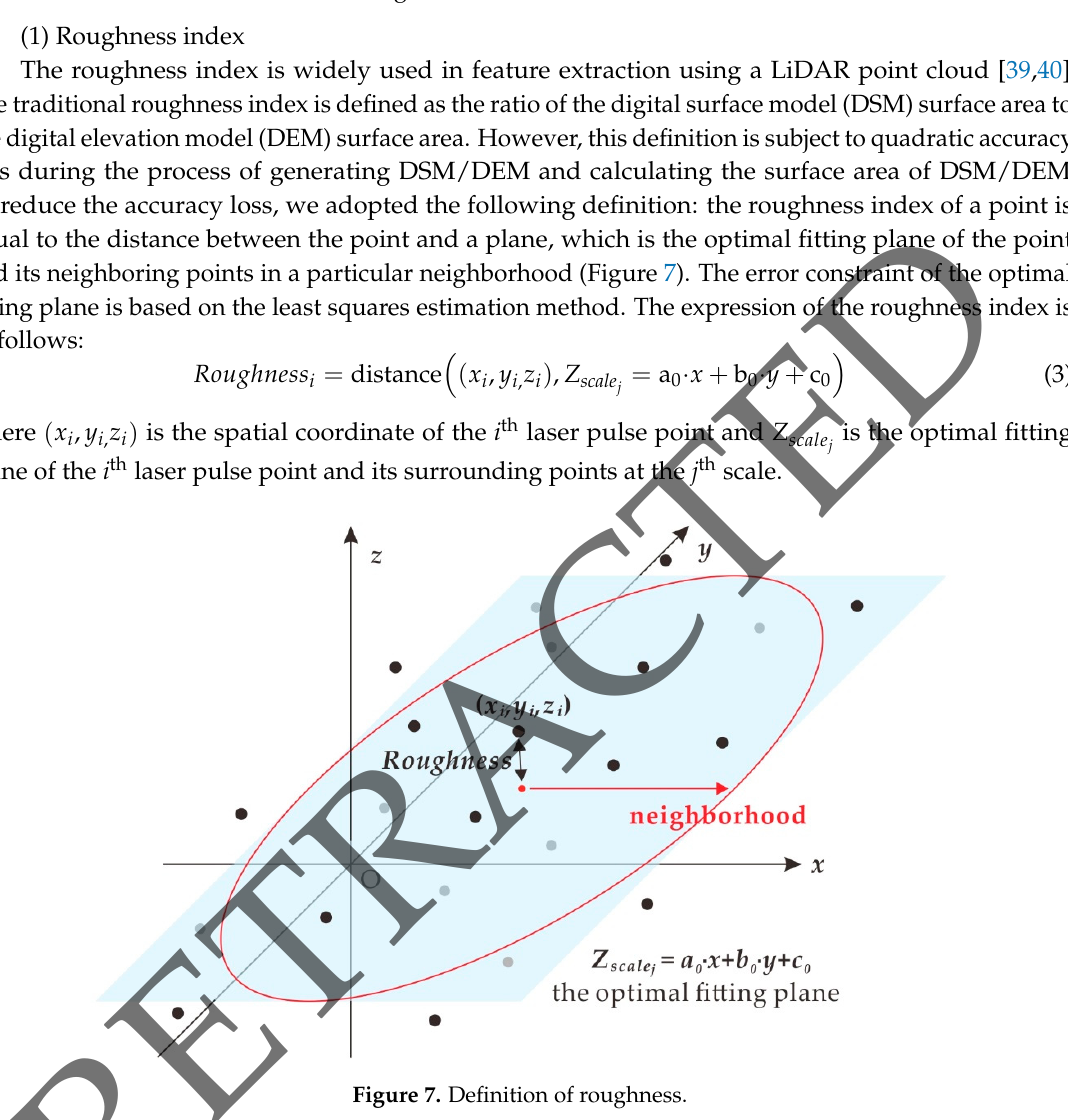
Figure 7. Definition of roughness.